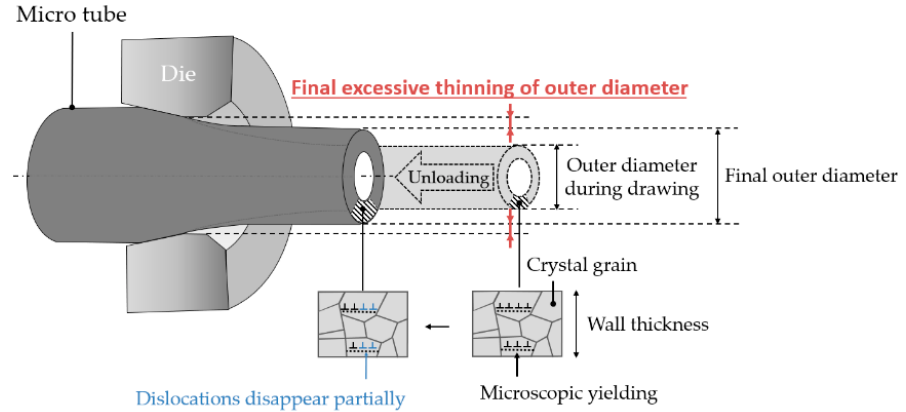
Figure 25. Schematic illustration of excessive thinning of the outer diameter during drawing and after unloading.